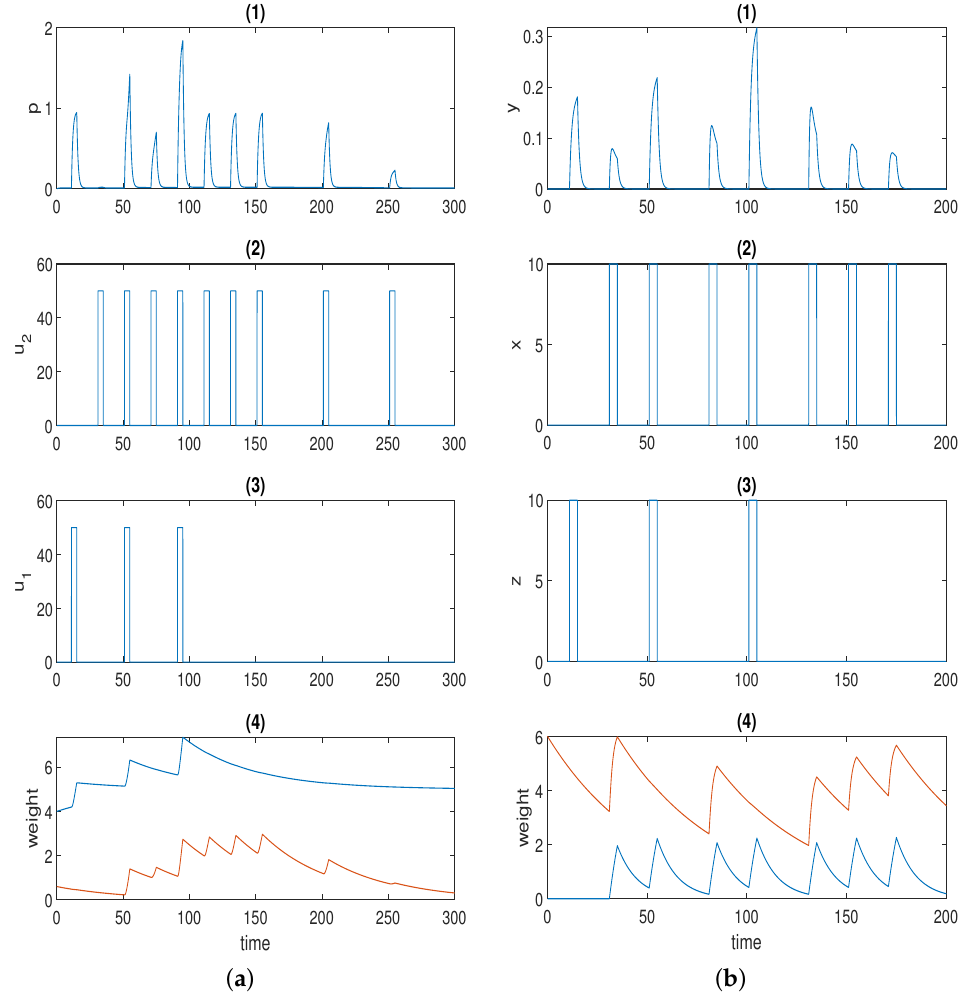
Figure 3. ( a ) Time series for Fernando’s model: (1) response molecule p ; (2), (3) conditioned stimulus u 2 and unconditioned stimulus u 1 ; (4) weight molecule ω 1 (blue) and ω 2 (red); α = 1, β = 0.8, θ = 0.02, τ = 0.1, S = 10. ( b ) Time series for the model with forced dissociation (1) response molecule y ; (2), (3) conditioned stimulus x and unconditioned stimulus z ; (4) weight molecule u (blue) and v (red); a = 2, α yx = 2, α yz = 4, α xyz = 4, α ux = 0.6, α vx = 1.5, β u = 0.1, β v = 0.02. In (1), the first spike was stimulated by the unconditioned stimulus, and the second spike was triggered by the conditioned stimulus; the first and second conditionings were formed at the third and fifth spikes, respectively; the first and the second learned responses were reflected by the fourth and the sixth spikes; the remaining spikes demonstrate whether the forced dissociation could be realised or